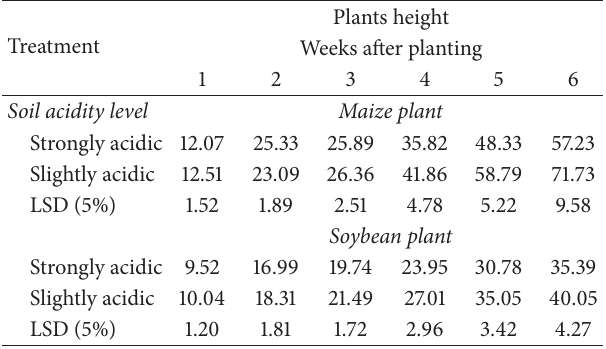
Table 4: Influence of P-sourceson biomass yield (g/pot) and relative agronomic efficiency (RAE) (%) of maize/soybean plants in the first cropping.